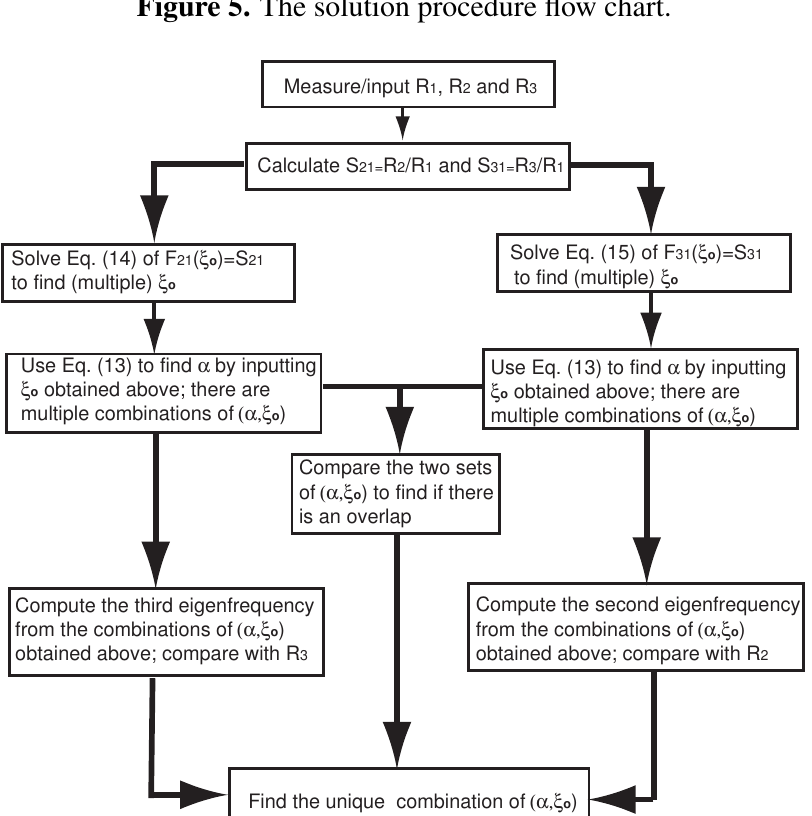
Figure 5. The solution procedure flow